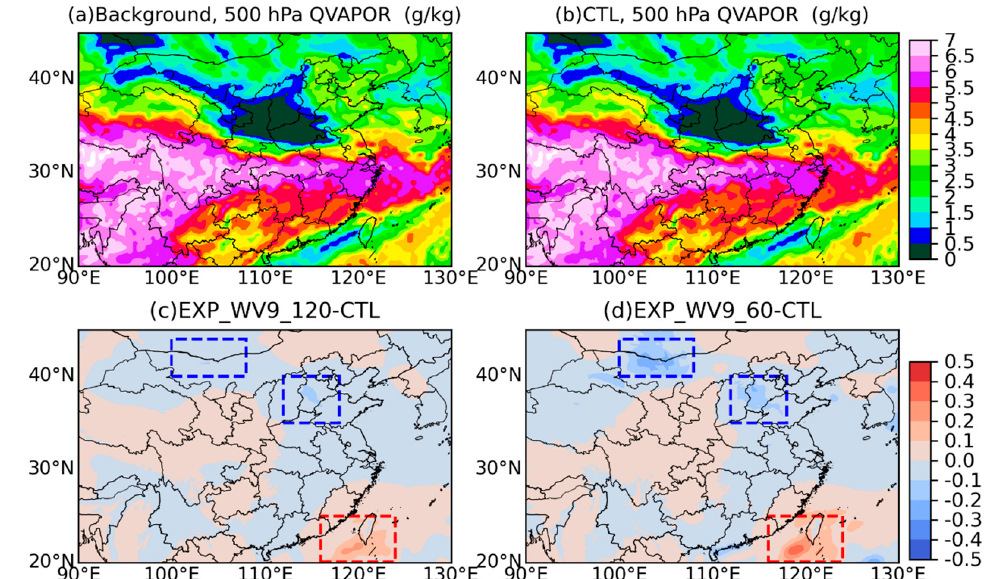
Figure 4. Spatial distributions of 500 hPa water vapor (g kg − 1 ) of ( a ) the background (NoDA) and ( b ) the CTL; the 500 hPa water vapor increments (g kg − 1 ) between EXP_WV9 and CTL, at ( c ) 120 km and ( d ) 60 km AGRI thinning grid at 0000 UTC on 5 July 2020.